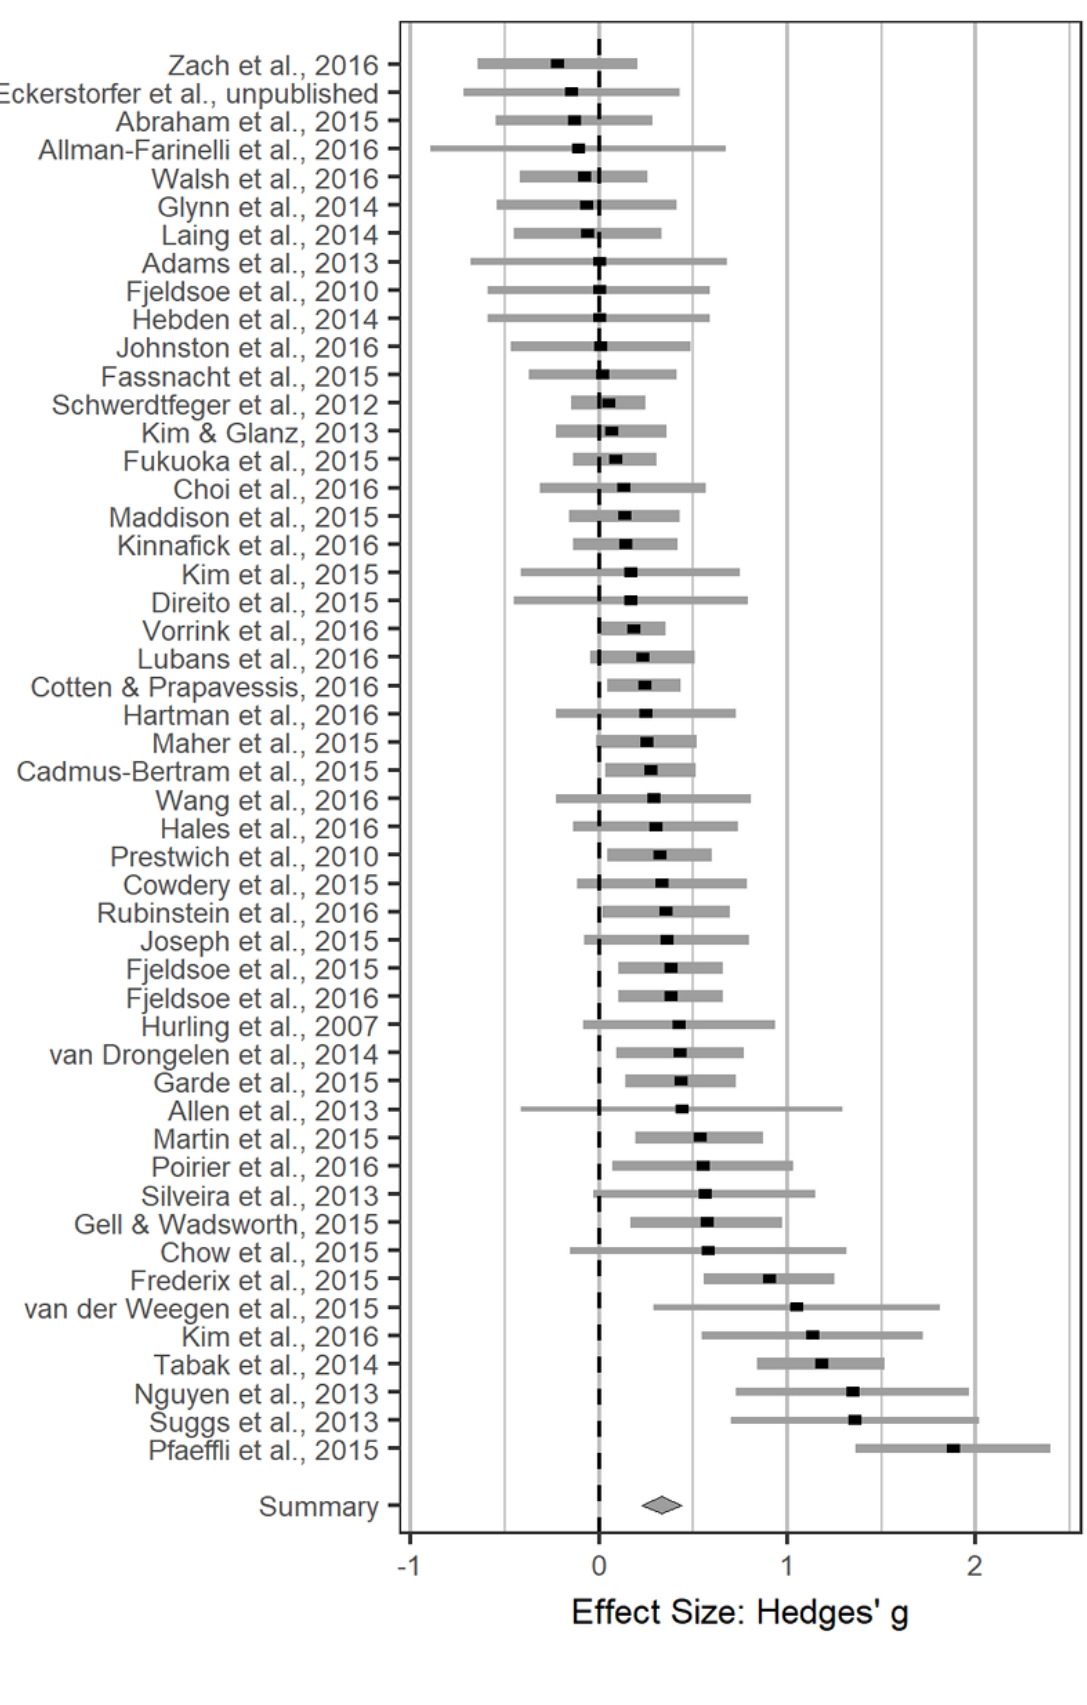
Figure 3. Forest plot for physical activity postintervention. The larger the values, the more active the intervention group was compared to the control group. Horizontal lines depict 95% CI and line thickness indicates each number's impact on the summary